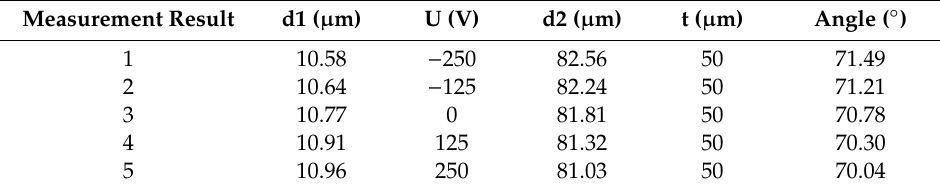
Table 1. Measurement results of the micro-cone hole under di ff erent voltages. (d1 is the small diameter of the cone hole, d2 is the large diameter of the cone hole, t is the thickness of the dispenser). Measurement Result